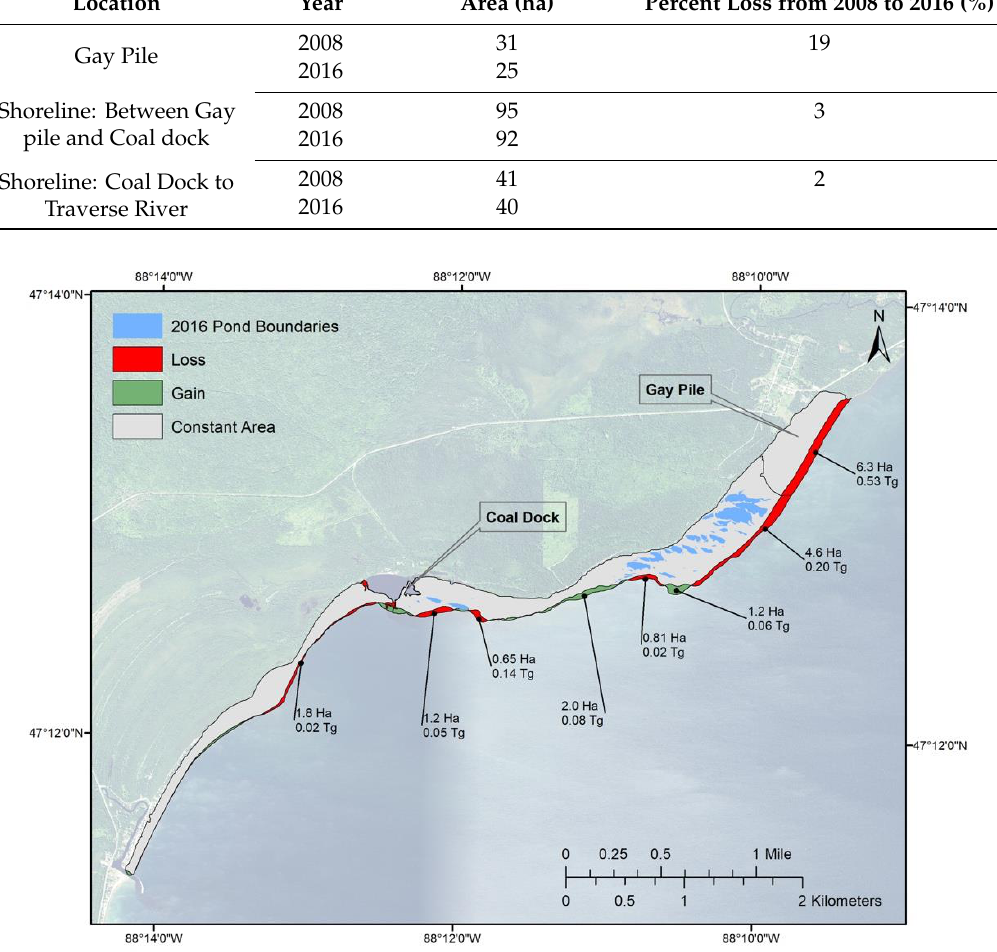
Figure 9. Coastline change from 2008 to 2016, based on LiDAR DEMs, displayed on 2016 NAIP orthoimagery. Shoreline area gain is displayed in deep green, loss in red and unchanged in grey. Areas of significant change are indicated in hectares, whereas volumes are in teragrams (Tg = MMt). Notice large losses at the original Gay tailings pile and along redeposited stamp sand beaches. Percentages are listed in Table 2. Table 2. Area and percentage of beach stamp sand lost, 2008 to 2016 (LiDAR).